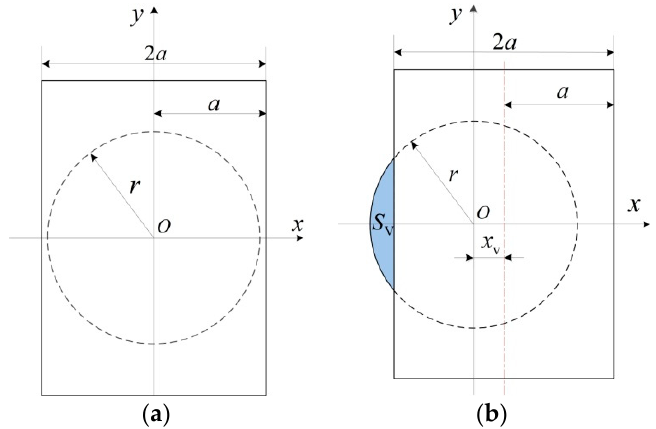
Figure 6. Relative position of the circular hole and the spool shoulder: ( a ) Initial position; ( b ) Relative position when displacement is x v .